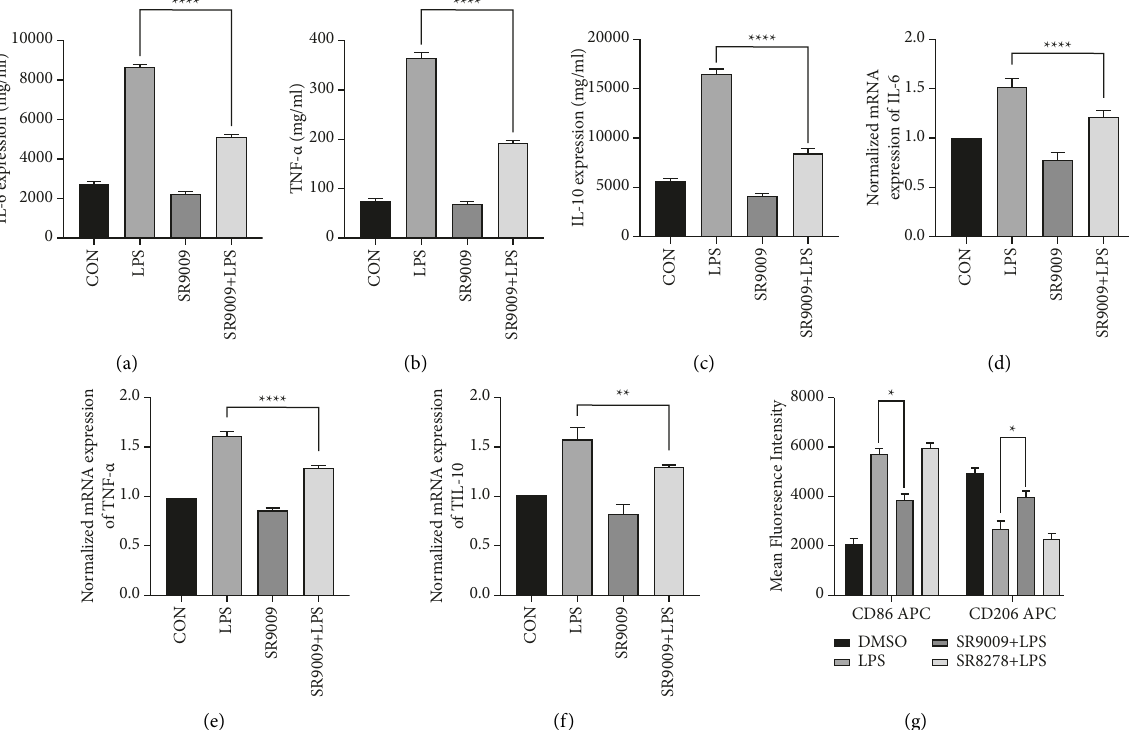
Figure 1: ELISA detection of proinflammatory cytokine production: (a) IL-6, (b) TNF- α , and (c) anti-inflammatory cytokine production IL- 10 in RAW246.7 cells after treatment with DMSO (control group), LPS, SR9009, and SR9009+LPS, respectively. Normalized mRNA expressions of (d) IL-6, (e) TNF- α , and (f) IL-10 in RAW246.7 cells after treatment with DMSO (control group), LPS, SR9009, and SR9009+LPS, respectively. (g) Mean fluorescence intensity of CD86 and CD206 in RAW246.7 before and after Rev-erb α regulation. Significant differences: ∗ p < 0 . 05, ∗∗ p < 0 . 01, ∗∗∗ p < 0 . 001, and ∗∗∗∗ p < 0 .